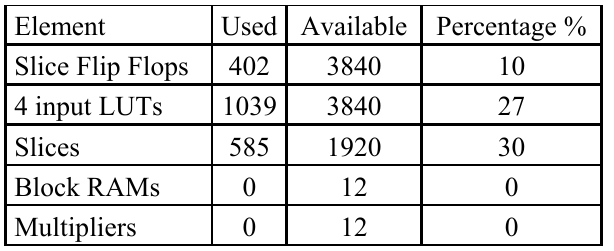
Table 3. FPGA resources utilization for the coordinator *.